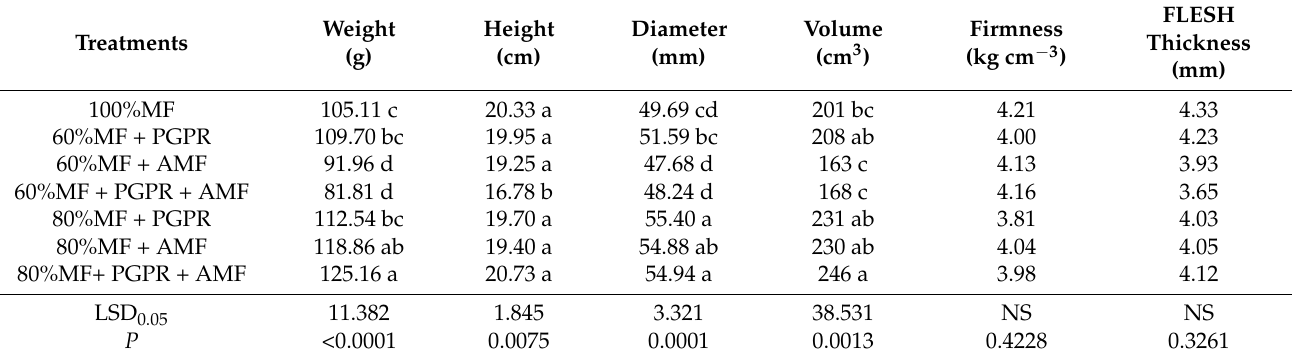
Table 4. Effects of the treatments on the physical properties of capia pepper fruit.